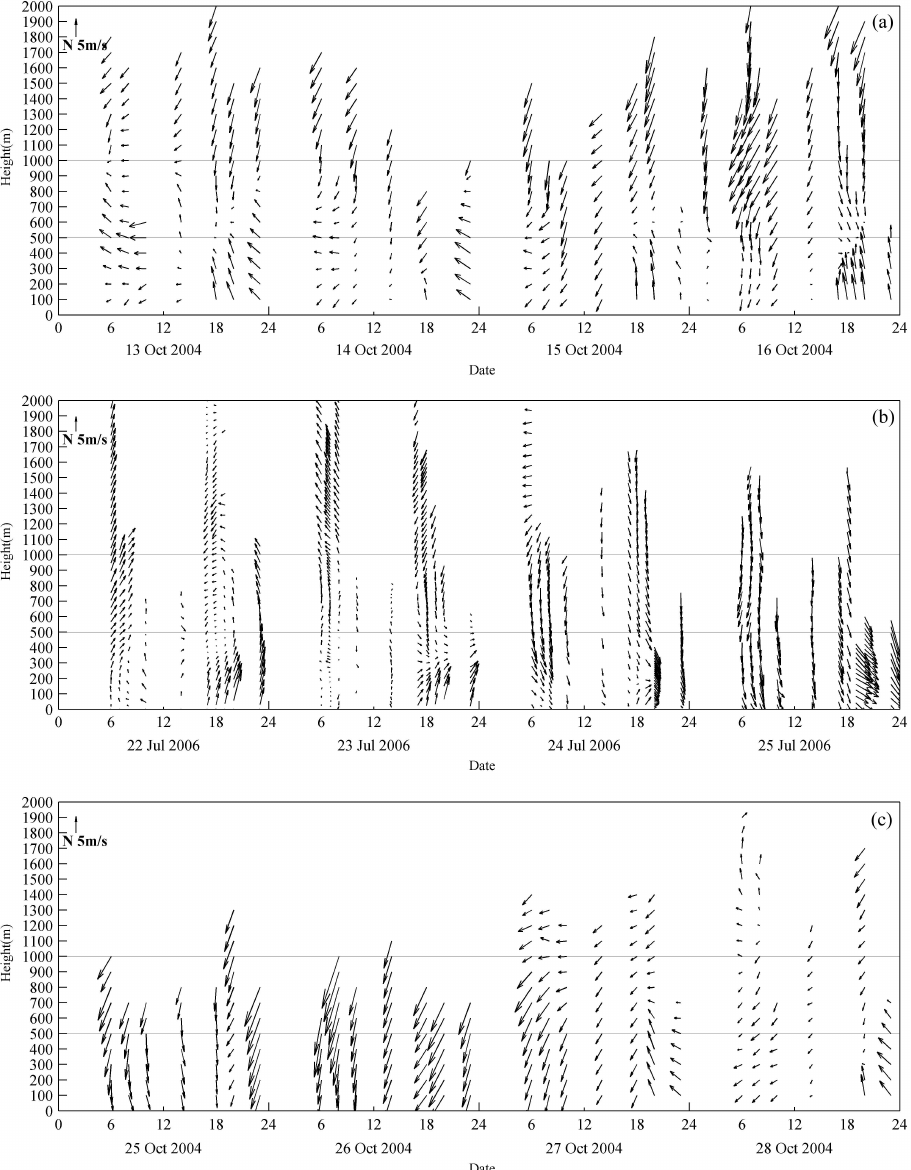
Fig. 4. Time series of vertical wind profiles at the Xinken station (a) from 13 to 16 October 2004, (b) 22 to 25 July 2006, and (c) 25 to 28 October